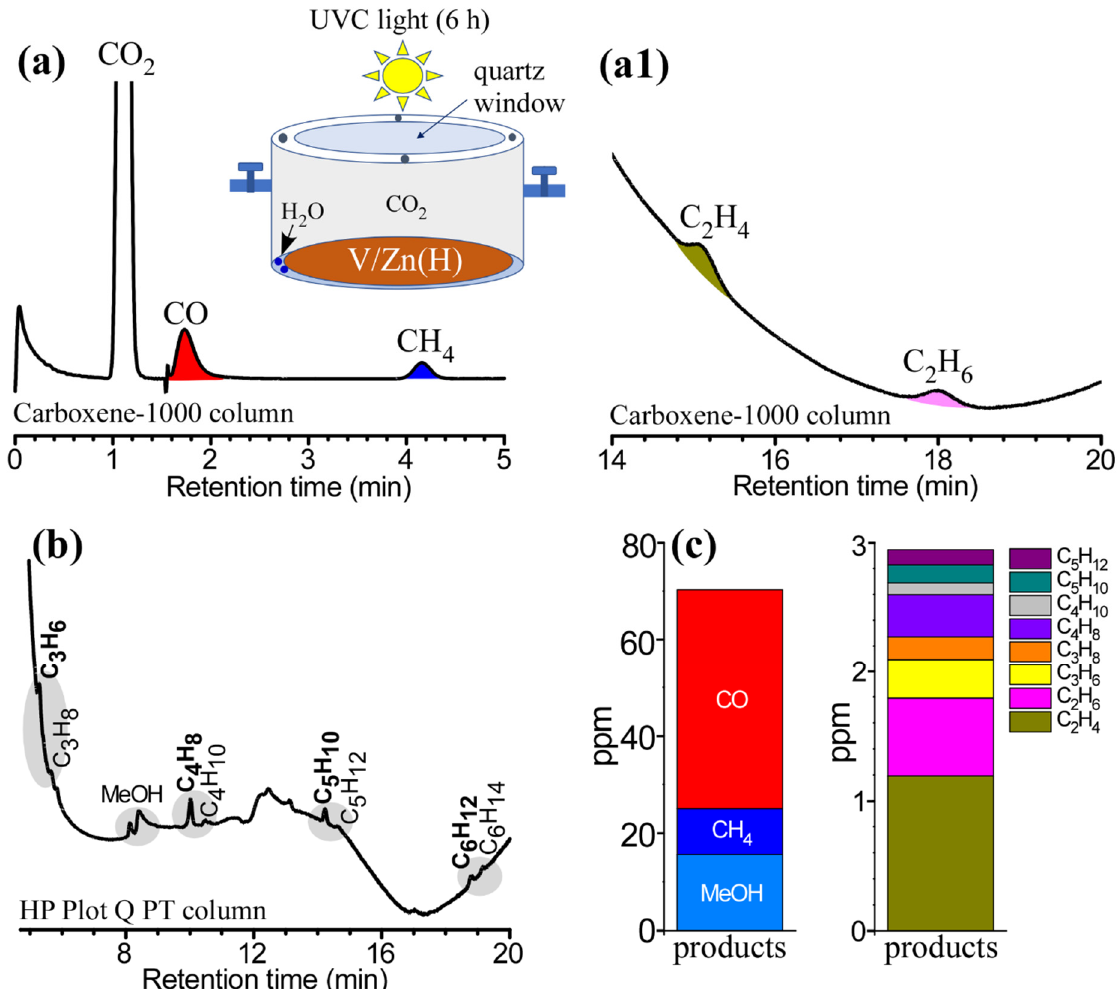
Figure 5. GC profiles separated by Carboxene-1000 column ( a , a1 ) after photocatalytic CO 2 RR for 6 h under UVC irradiation. Inset is a schematic of a closed stainless-steel reactor. GC profile separated by HP Plot Q PT column ( b ). Consequent photocatalytic CO 2 RR product amounts ( c ).